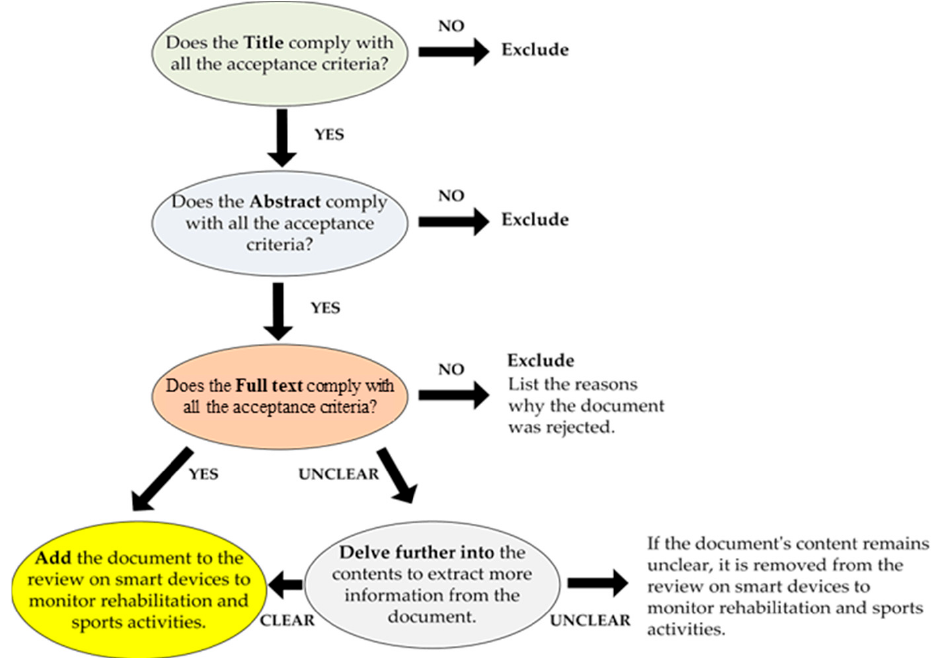
Figure 1. Workflow describing the selection process involved in the presented review paper.